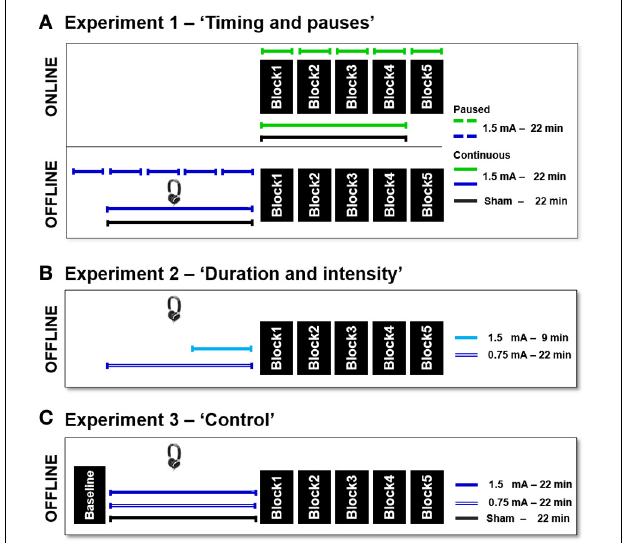
FIGURE 2 | Experimental procedure. (A) Experiment 1: in the top panel, the green lines represent the online conditions. In the bottom panel, the blue lines represent the offline conditions. The dashed lines represent the paused stimulations, whereas the continuous lines the continuous stimulations. The sham condition is shown in black lines. (B) Experiment 2 (offline conditions): the short turquoise line represents 1.5mA for 9min, and the double blue line represents 0.75mA for 22min. (C) Experiment 3 (offline conditions): the blue line represents 1.5mA for 22min, the double blue line represents 0.75mA for 22min, and the black line represents sham for